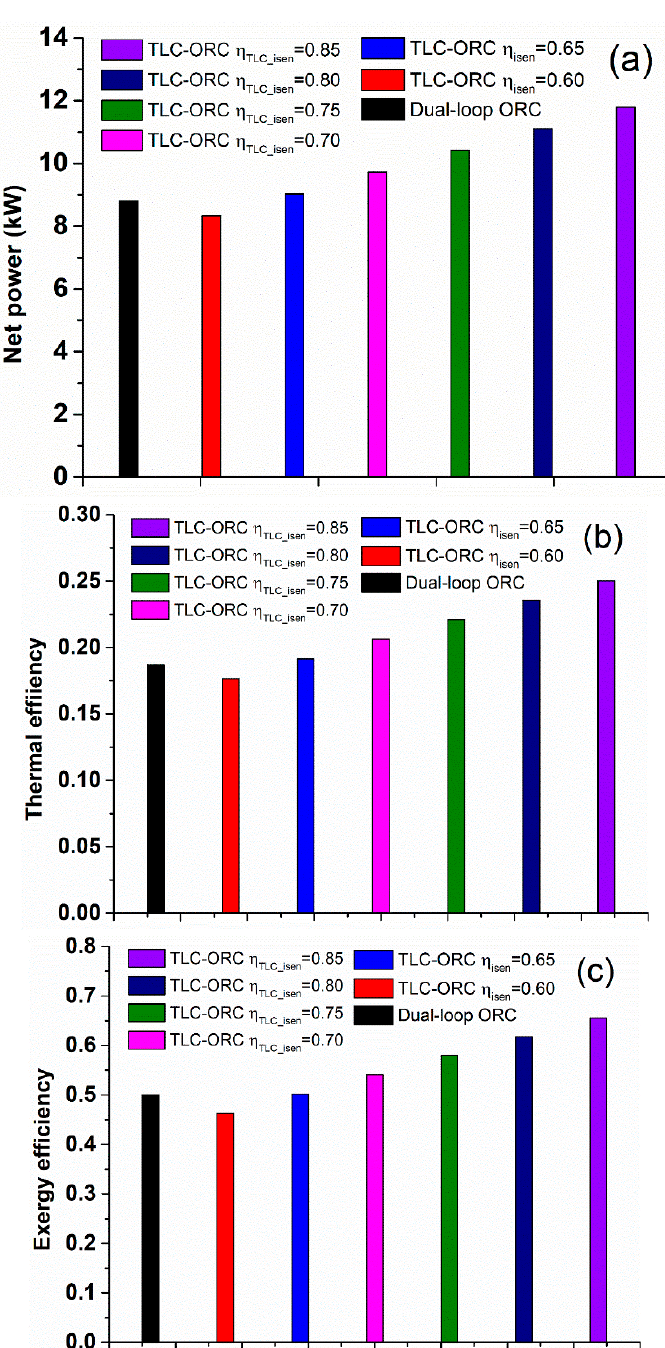
Figure 16. The maximum system performance of the proposed TLC-ORC with different TLC expander isentropic efficiency. ( a ) Comparison between the maximum net power of the TLC-ORC under various TLC isentropic efficiency and the dual loop ORC; ( b ) Comparison between the maximum thermal efficiency of the TLC-ORC under various TLC isentropic efficiency and the dual loop ORC; ( c ) Comparison between the maximum exergy efficiency of the TLC-ORC under various TLC isentropic efficiency and the dual loop ORC.